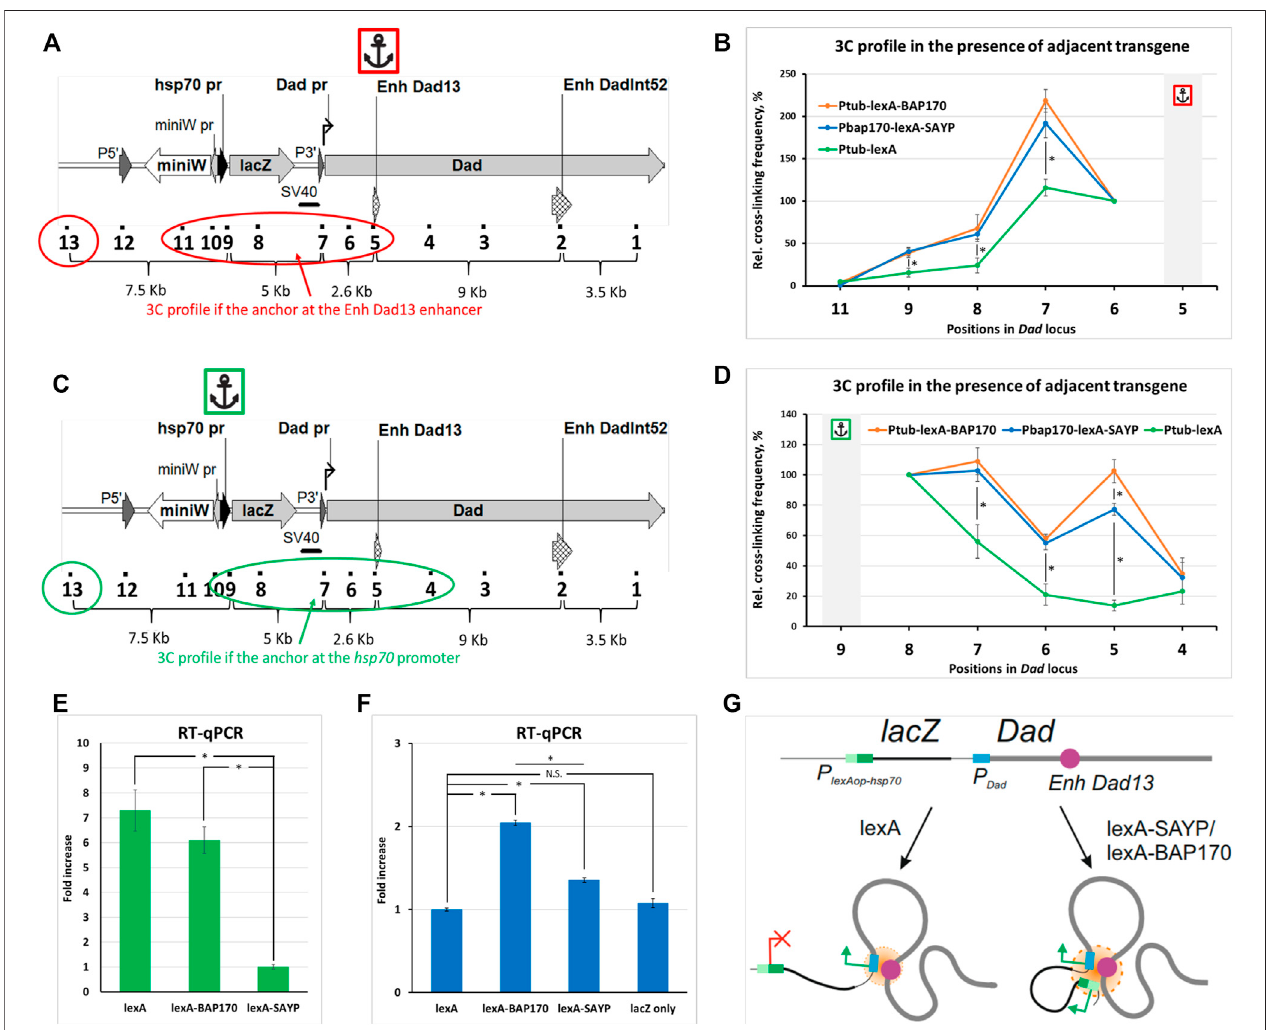
FIGURE 4 | Comparison of the 3C pro fi les in the Dad locus in the presence of an adjacent transgene. (A) The model locus Dad with the adjacent transgene is shown. Designations are as shown in Supplementary Figures S3A and S6 . A red circle and oval encompass the points under study. An anchor icon indicates the locationoftheanchorprimeratthe Dad13 enhancer. (B) Interactionpro fi lesforindicatedpositionsin Dad locuswiththeadjacentreportertransgenewereobtainedinthe presence of the P tub -lexA-BAP170, P BAP170 -lexA-SAYP, or control P tub -lexA driver transgene with the anchor at the Dad13 enhancer. Extraction, collection, and processing of larvae and 3C library preparation were done as shown in Figure 2B for larvae except that 150 larvae were collected and 50 mg of larval cell material was taken for 3C library preparation. Seven independent 3C libraries were prepared and analyzed for P tub -lexA-BAP170 and P BAP170 -lexA-SAYP larvae and 4, for control P tub -lexAlarvae(twoforeachcrossoverline#2and#6,respectively).The3Cexperimentwasdoneasshownin Figure2C exceptthaterrorbarsindicateSEMsfrom7or 4 independent biological replicates ofthe 3Clibrary for each case, respectively. Each experimental point for each 3C librarywasstudied in 2 – 4technical PCR replicates, and the data were averaged. Point 10 was excluded from the analysis since points 9 and 10 are adjacent. The RLFs of experimental samples were normalized to RLFs within the constitutively expressed RpII locus and to point #13 (intergenic spacer). The values between the two normalizations were averaged. An asterisk indicates the signi fi cance level: * p < 0.05, n = 12. (C) The same as shown in (A) , but the anchor is at the P lexAop-hsp70 -lacZ promoter and the points under study are encompassed in green. (D) Thesameasshown in (B) ,but theanchor isattheP lexAop-hsp70 -lacZ promoter.Thenumber oftheprepared and analyzed 3Clibraries isthesame asshown